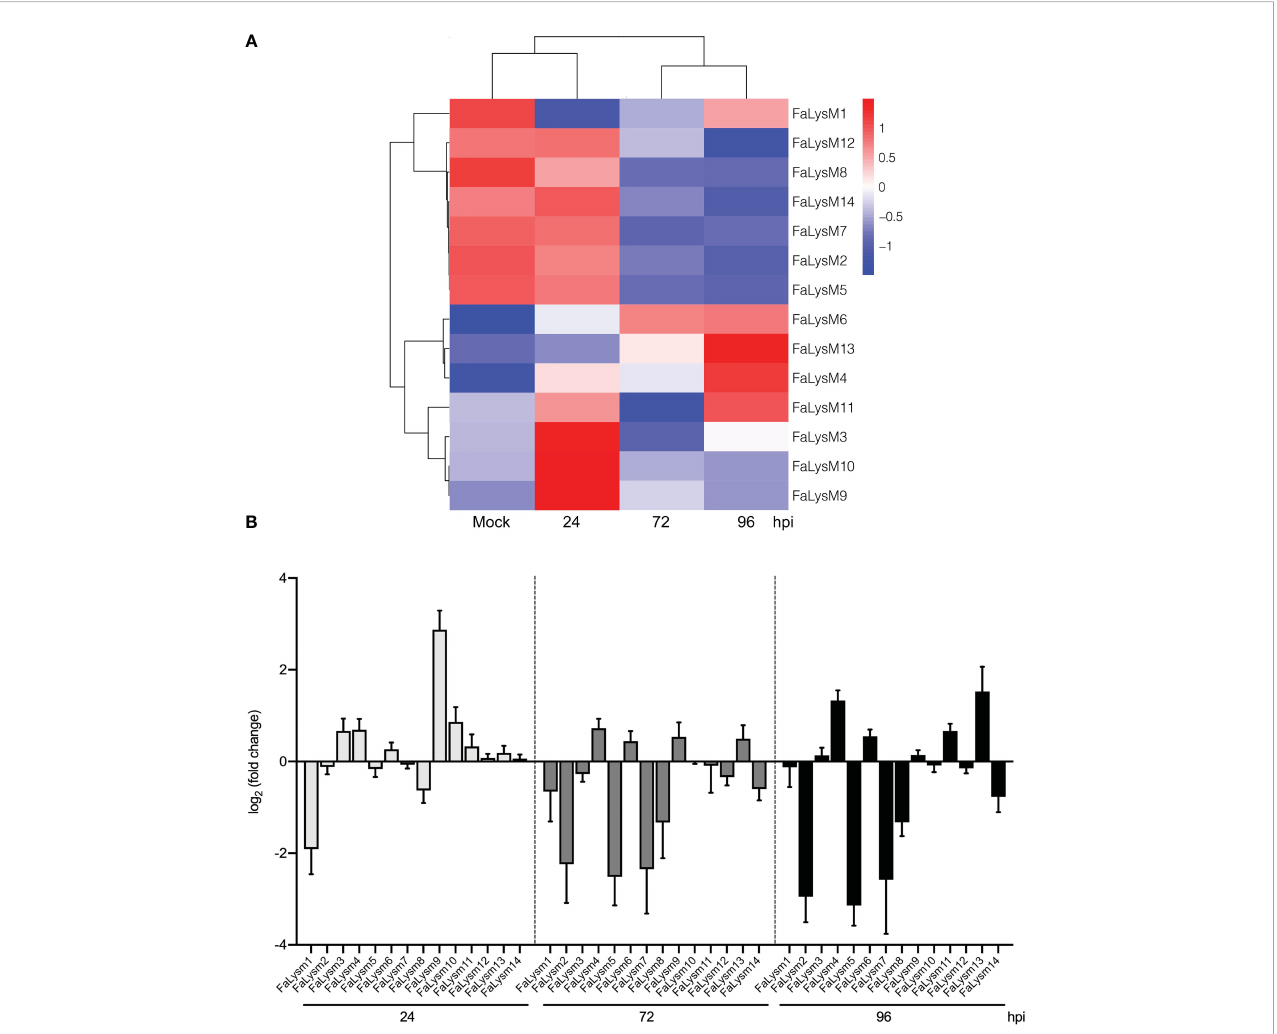
FIGURE 6 The expression patterns of FaLysM genes in octoploid strawberry leaves infected with C. fructicola at different stages (24, 72 and 96 hpi). (A) The heat map analysis of 14 differentially expressed FaLysM genes in strawberry leaves infected with C. fructicola at 24, 72 and 96 hpi. Mock: Mock treatment with water containing Tween -20. (B) The relative expression levels of FaLysM genes in strawberry leaves infected with C. fructicola at 24, 72 and 96 hpi. Error bars represent the standard error of the mean. x-axis shows genes in three time points validated in this study; y-axis shows the log2 ratio of FaLysM gene expression in infected strawberry (24, 72 and 96 hpi) versus mock inoculated